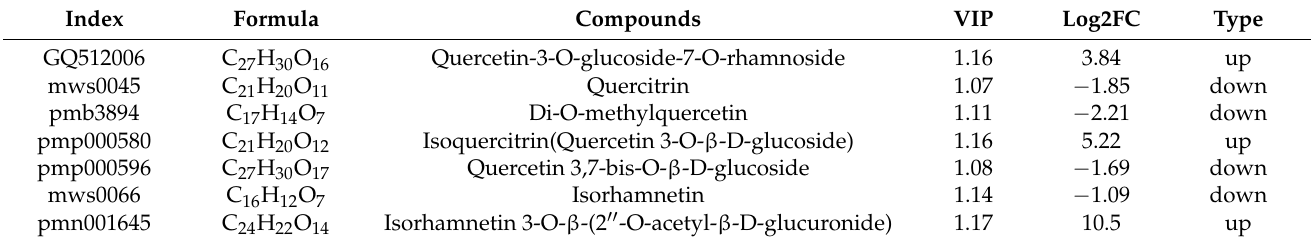
Table 3. Differential metabolites associated with flavonoid synthesis within stems and leaves of mature A. ilicifolius